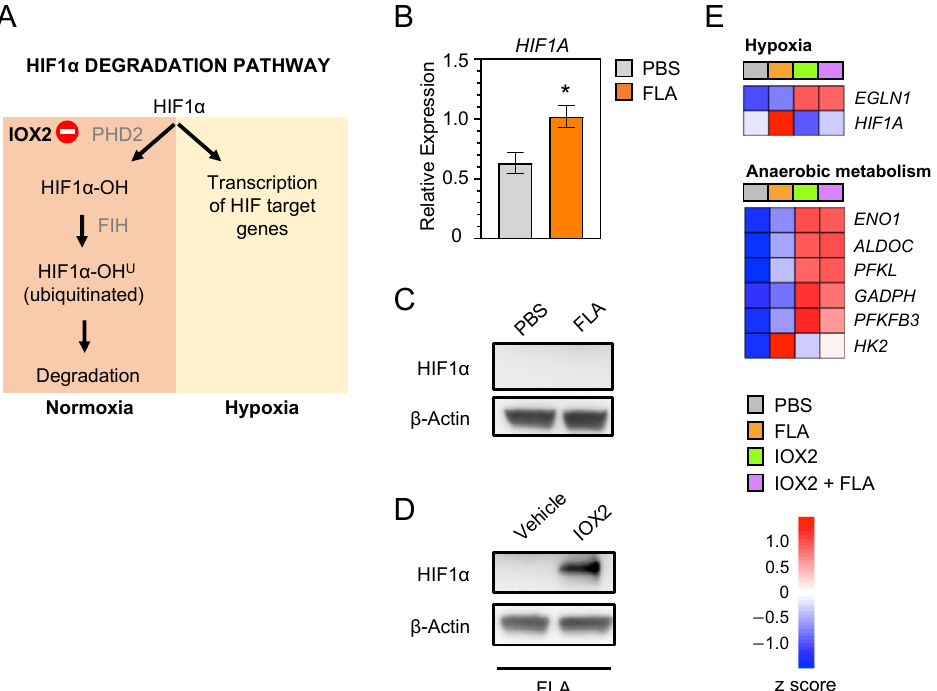
Figure 1. HIF1 α stabilization in HBE cells ( A ) Scheme of the HIF1 α degradation pathway. ( B ) Fold increase in mRNA expression for HIF1A analyzed via RT-PCR in HBE cells 24 h after stimulation with flagellin (1 µ g/mL) or PBS (control). ( C ) HIF1 α Western blot of HBE cell lysates after stimulation with flagellin or PBS for 24 h; β -actin was used as loading control. ( D ) HIF1 α blot in HBE cells pre-treated for 1 h with IOX2 (50 µ M) or vehicle and stimulated for 24 h with flagellin; β -actin was used as loading control. ( E ) Heat map of changes in the expression of selected genes from the HIF1 α pathway in HBE cells as in ( D ). Red denotes high expression; blue indicates low expression. Data in ( B ) are presented as mean ± SEM ( n = 6). p value was calculated using Student’s t test compared to control cells. * p < 0.05. Data in ( C ) and ( D ) are representative of two independent experiments wherein similar results were obtained. Data in ( E ) comprise 3 biological donors with 1–2 replicates from 2 independent experiments ( n = 5).